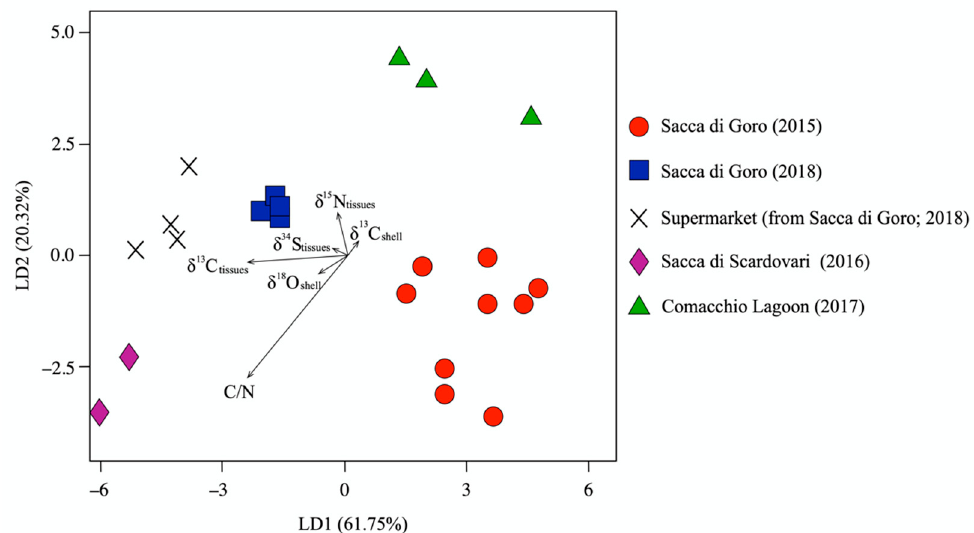
Figure 7. Linear discriminant analysis (LDA) of δ 13 C, δ 15 N, C/N, and δ 34 S C/N of tissues and δ 13 C and δ 18 O of shells of manila clams collected on-site from northern Adriatic lagoons and bought at a local supermarket.